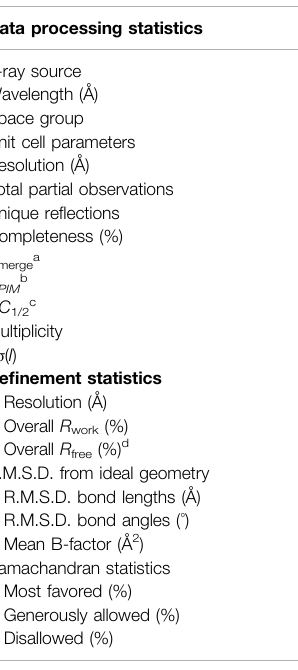
TABLE 1 | Data processing and model re fi nement statistics (PDB ID